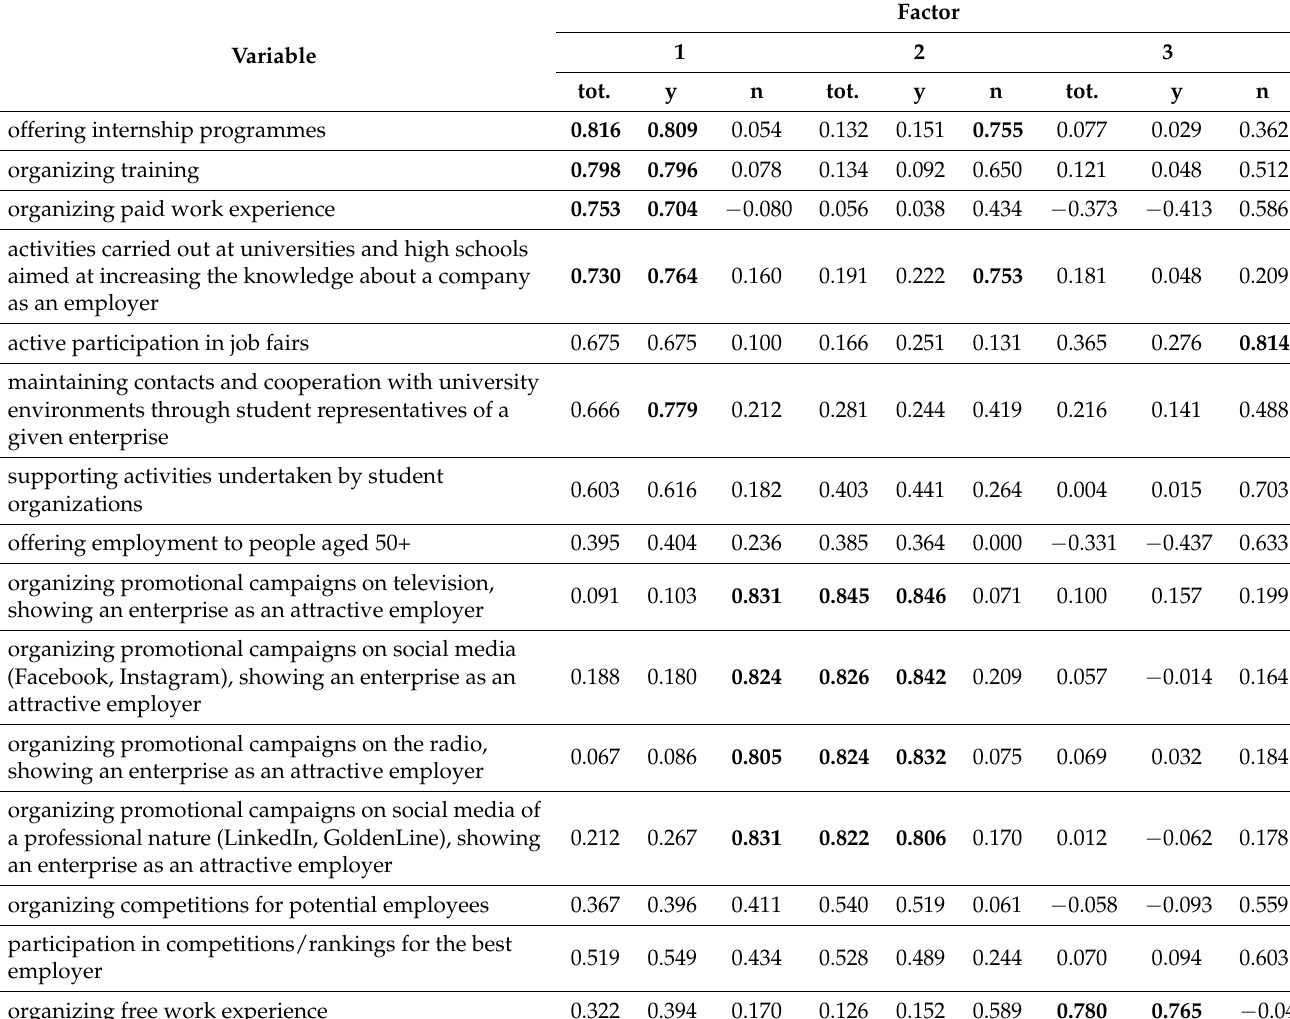
Table 3. The results of factor analysis of activities undertaken by enterprises depending on respondents’ opinions on whether the employer’s image created on the basis of modern marketing communication channels is more beneficial than the employer’s image created on the basis of classical marketing communication